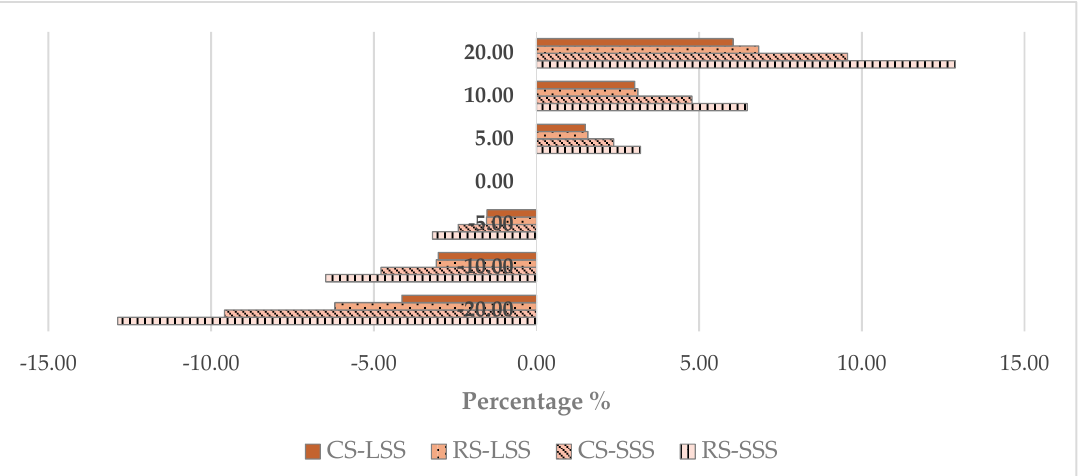
Figure 8. Sensitivity analysis—total cost vs. hourly wage (RS—Robotic System; CS—Conventional System; SSS—Small-Scale Scenario; LSS—Large-Scale Scenario).